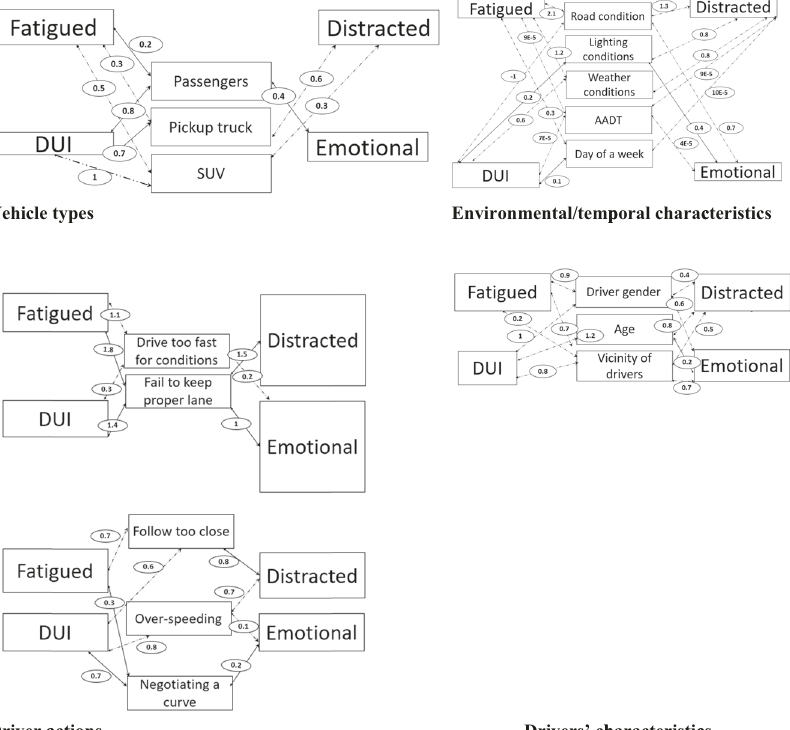
Fig. 3 Associations between various variables and impaired driving, dashed lines highlight negative associations, while the solid lines show the positive associations, absolute magnitude in circle, here to provide a better perspective we highlight and depict the associations in fi gures for a better